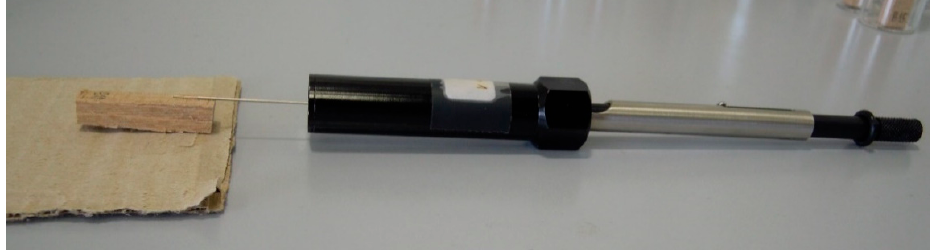
Figure 4. SPME sampling of model wood sample in contact mode.